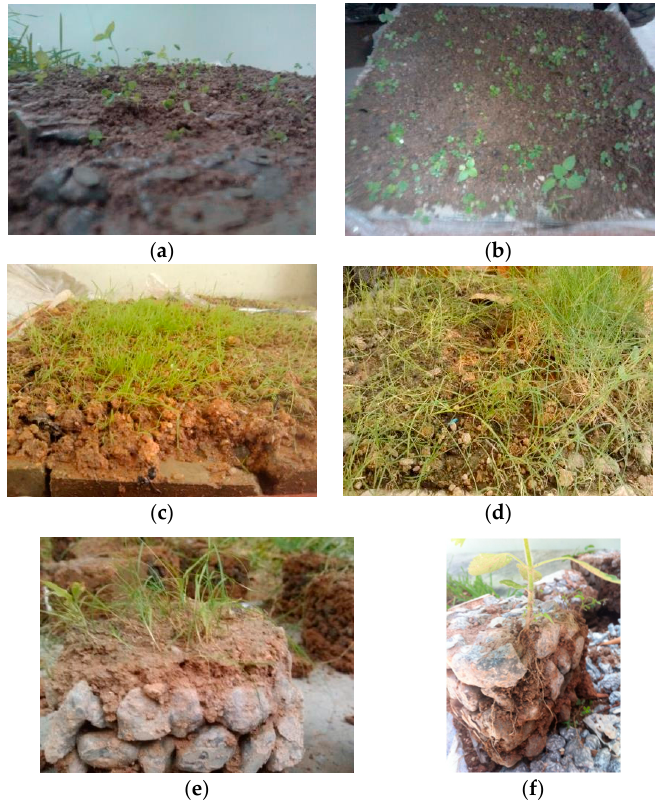
Figure 12. Vegetation growth after seeding on vegetative pervious concrete with 3.6% admixture after ( a ) one week; ( b ) three weeks; ( c ) five weeks; and ( d ) 10 weeks; ( e ) close-up view of the grass after ten weeks; and ( f ) roots grew through internal pores of vegetative pervious concrete.